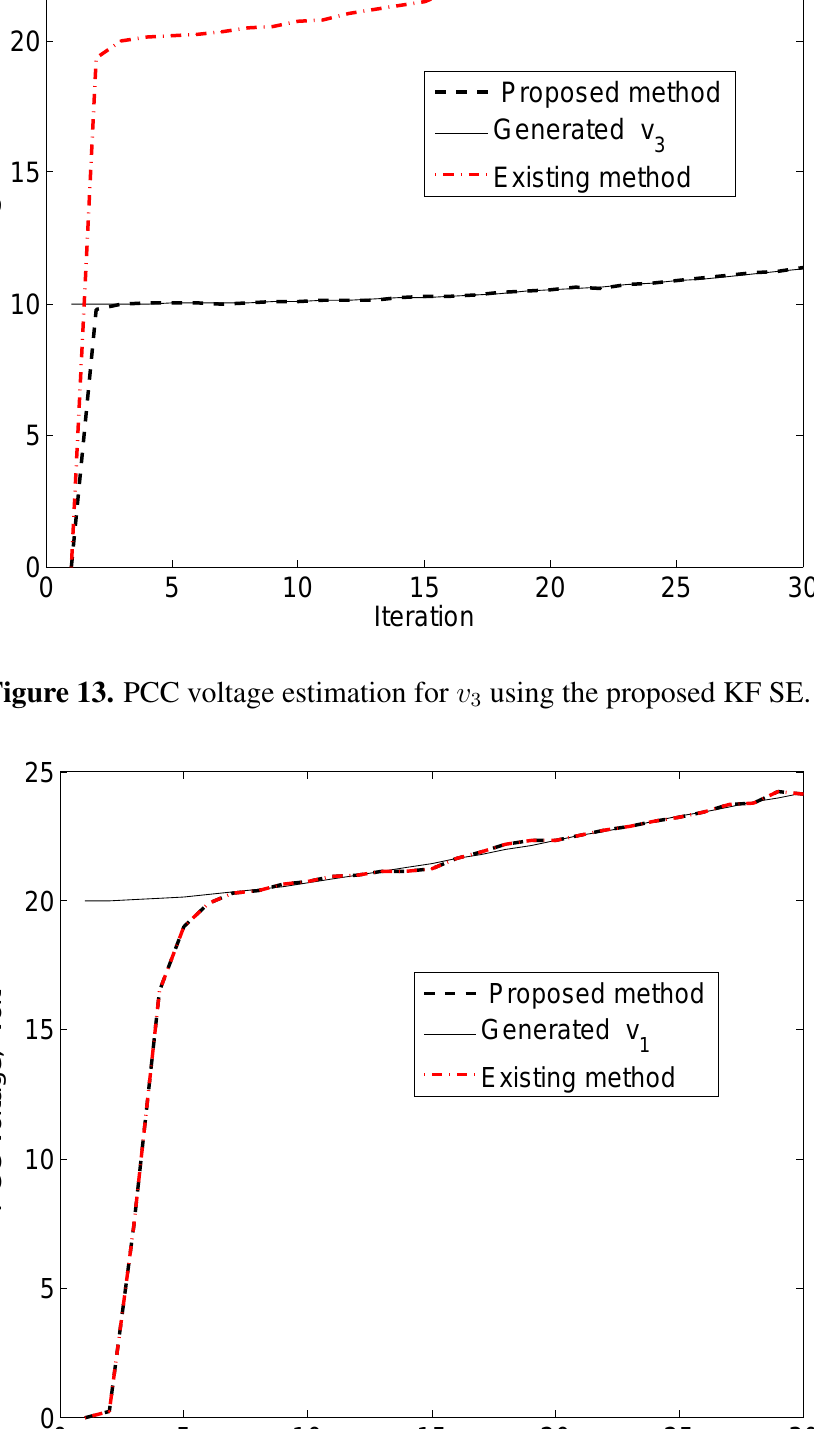
using the proposed KF SE with two faulty 1